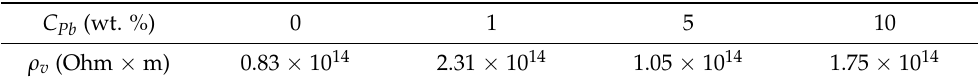
Table 2. Results of measurement of ρ v composite materials based on Pb -containing nanoparticles (author’s results).